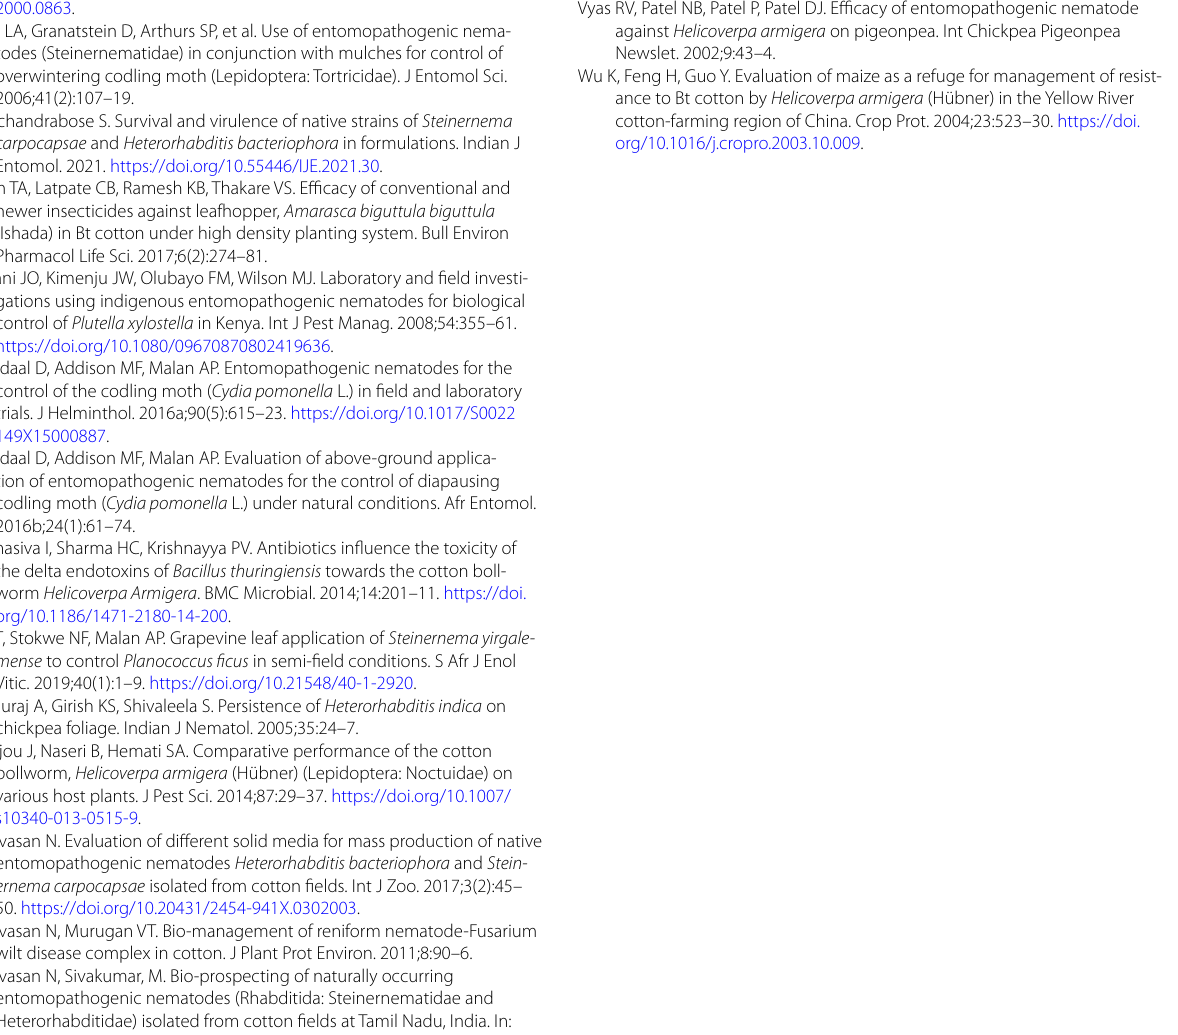
Tabashnik BE, Carrière Y. Global patterns of resistance to Bt crops highlighting pink bollworm in the United States, China, and India. J Econ Entomol. 2019;112(6):2513–23. https:// doi. org/ 10. 1093/ jee/ toz173. Vyas RV, Patel NB, Patel P, Patel DJ. Efficacy of entomopathogenic nematode against Helicoverpa armigera on pigeonpea. Int Chickpea Pigeonpea Newslet.